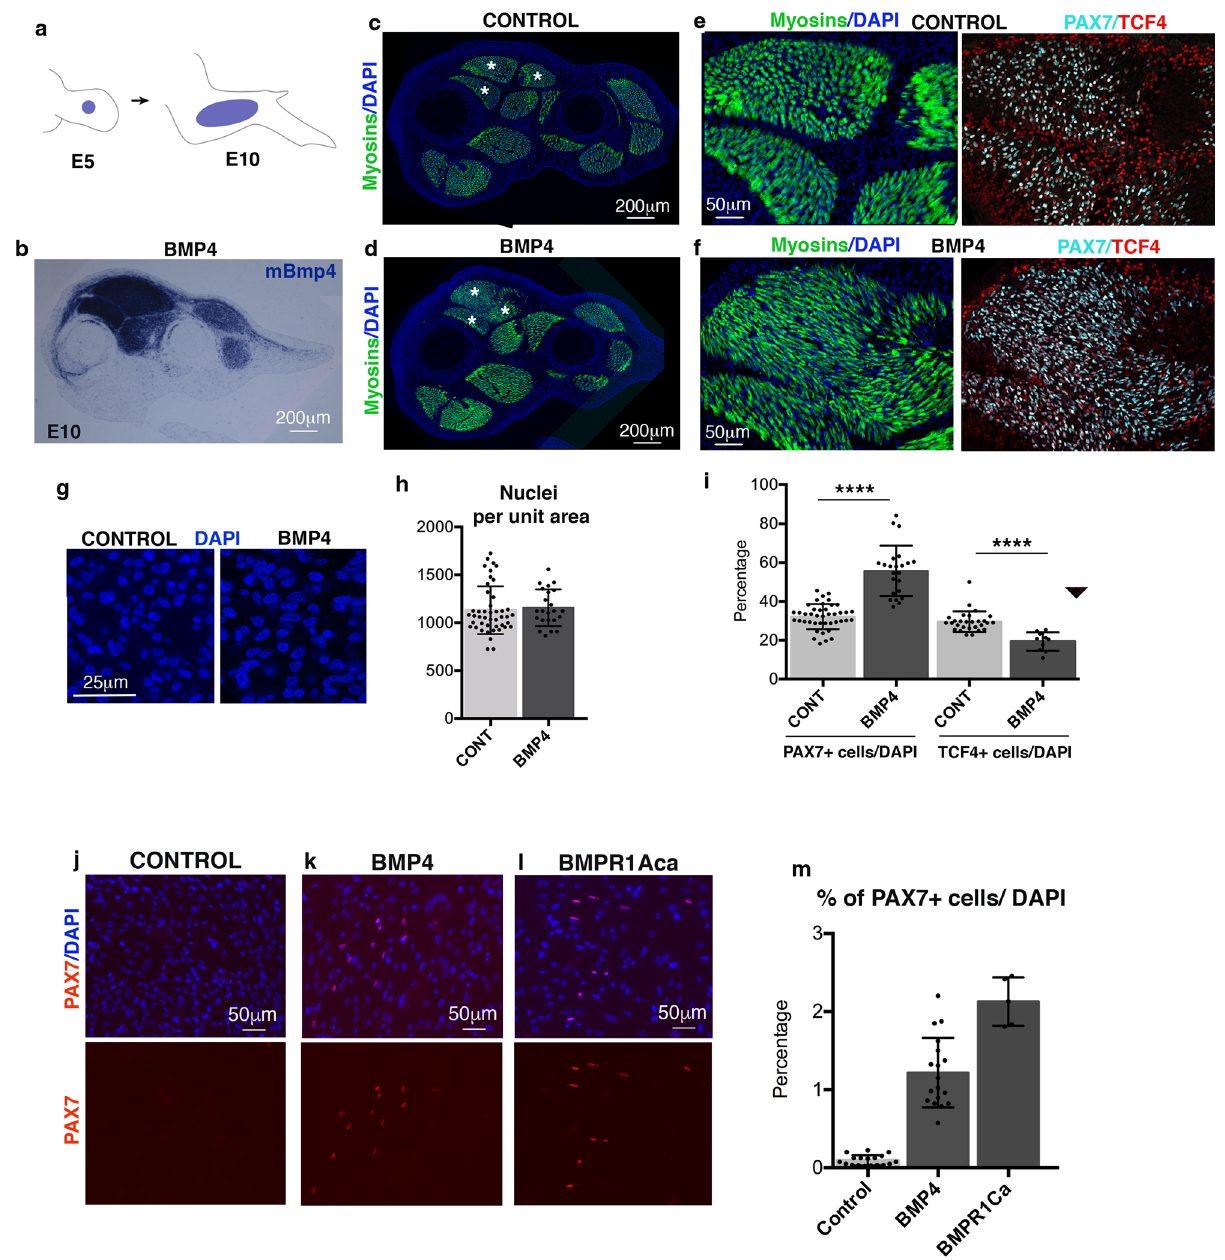
Fig. 7 BMP gain-of-function experiments in limbs and fi broblast cultures. a – i BMP4/RCAS-producing cells were grafted to the right limbs of E5 chicken embryos ( a ). Embryos were fi xed 5 days later at E10. In situ hybridisation experiments with mBmp4 probe to transverse limb sections indicate the extent of ectopic BMP4 expression in dorsal limb muscles ( b ). c – f Limb sections were immunostained with MF20 (myosins, green) to visualise the muscle pattern. Asterisks indicate fused muscles in BMP4-grafted limbs ( d ) versus individual muscles in control limbs ( c ). e , f High magni fi cations of dorsal limb muscles immunostained with MF20 (myosins, green), PAX7 (cyan) and TCF4 (red) antibodies in BMP4 ( f ) and control limbs ( e ). g , h Representative fi elds of nuclei (DAPI + ) in muscles of control and BMP4 limbs ( g ) and quanti fi cation of the number of nuclei per unit area ( h ). h Data are presented as mean of values ± SD from 5 BMP4 and 9 control limbs. i Percentages of PAX7 + and TCF4 + nuclei per total number of nuclei in BMP4-grafted limbs versus controls. Data are presented as mean values ± SD from 3 BMP4 and 6 control limbs. The p -value was obtained using the two-tailed Mann – Whitney test. Asterisks indicate the p -values, **** p < 0.0001. j – l Chicken fi broblast cultures transfected with empty/RCAS (control) ( j ), BMP4/RCAS ( k ) or BMPR1ca/ RCAS ( l ). Immunostaining with PAX7 antibody (red) and DAPI in BMP4- and BMPR1ca-transfected fi broblast cultures compared to controls. m Quanti fi cation of PAX7 + cells versus the total cell number. Data are presented as mean values ± SD from 3 independent